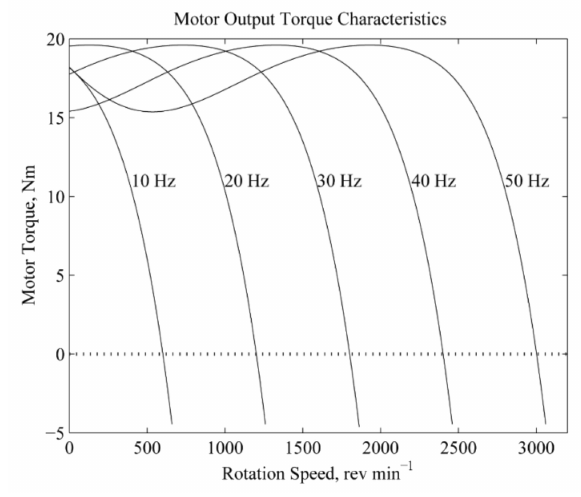
Figure 5. Motor load curve. Table 2. RV Expander Prototype